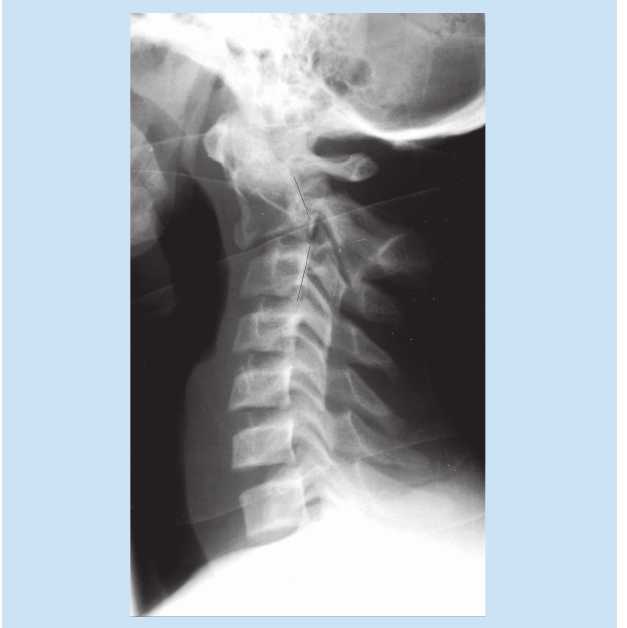
Fig. 1. The lateral cervical spine radiograph shows that the anteroposterior diameter measured between anterior and posterior margins of C2 is more than the same distance at C3 (there is no significant soft-tissue swelling present).